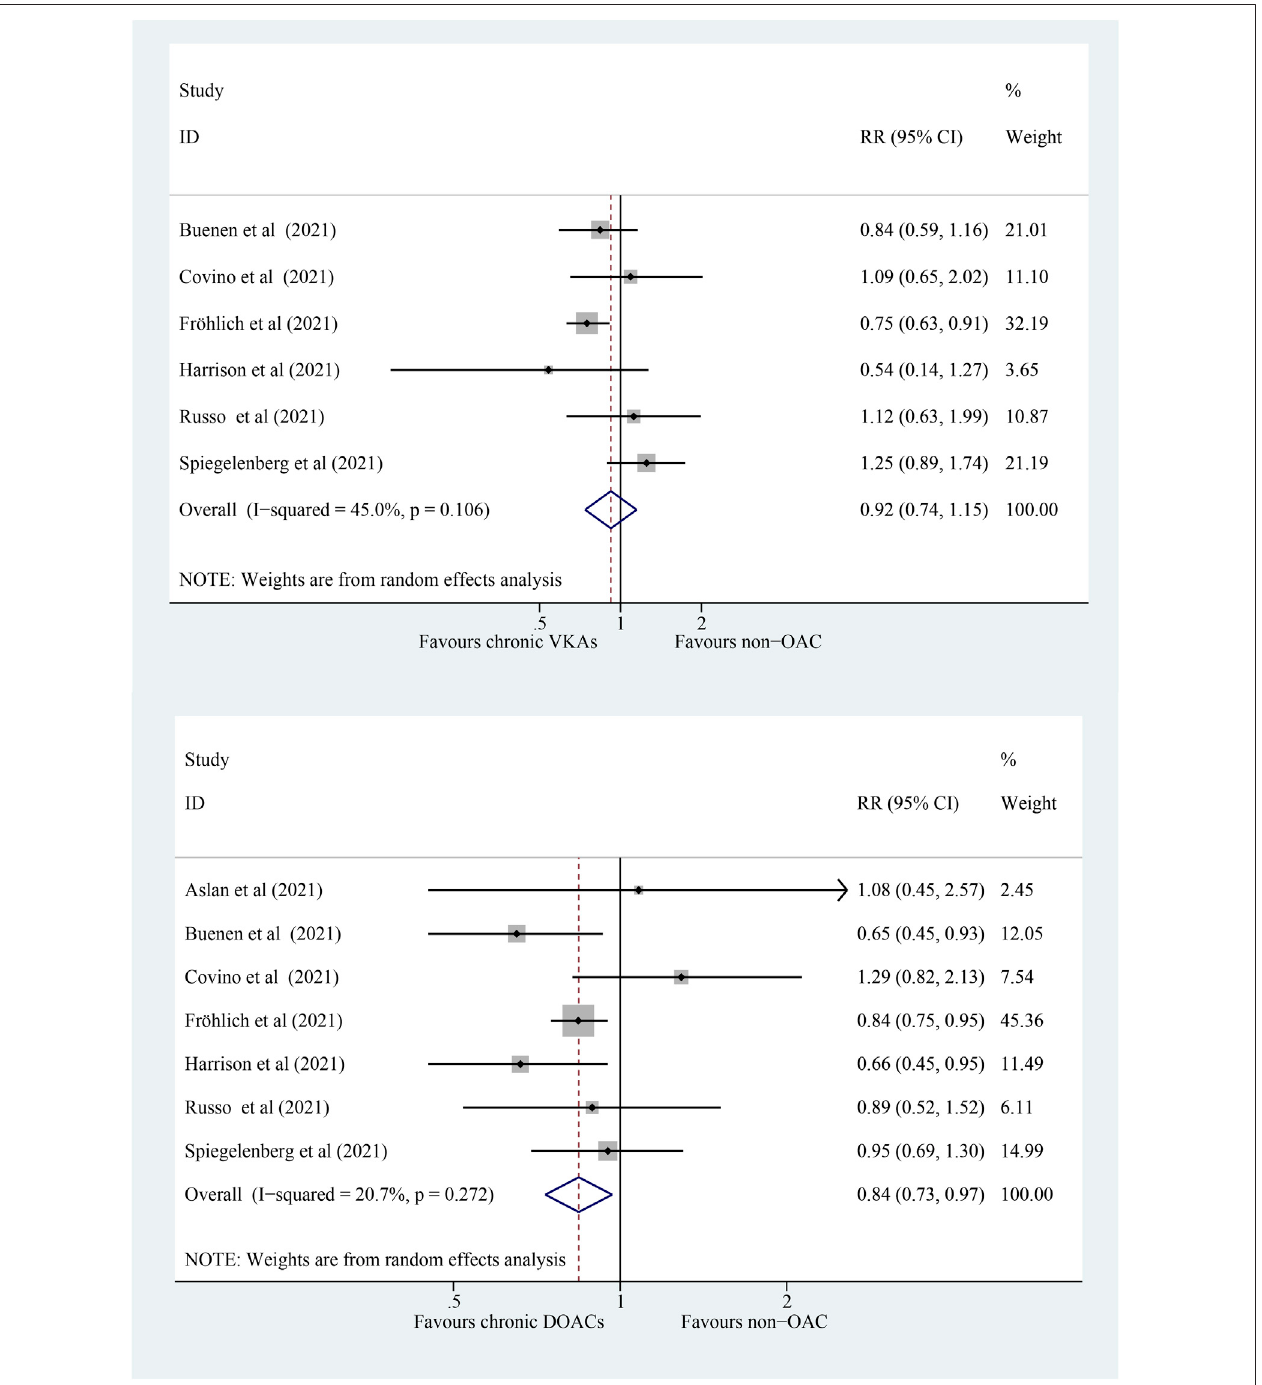
FIGURE 3 | Forest plot for the association of different types of OACs with all-cause mortality in COVID-19 patients, random model. (A) Chronic VKAs. (B) Chronic DOACs. OAC, oral anticoagulation; COVID-19, coronavirus disease 2019; RR, relative risk; CI, con fi dence interval; DOACs, direct oral anticoagulants; VKAs, vitamin K antagonists; P , heterogeneity